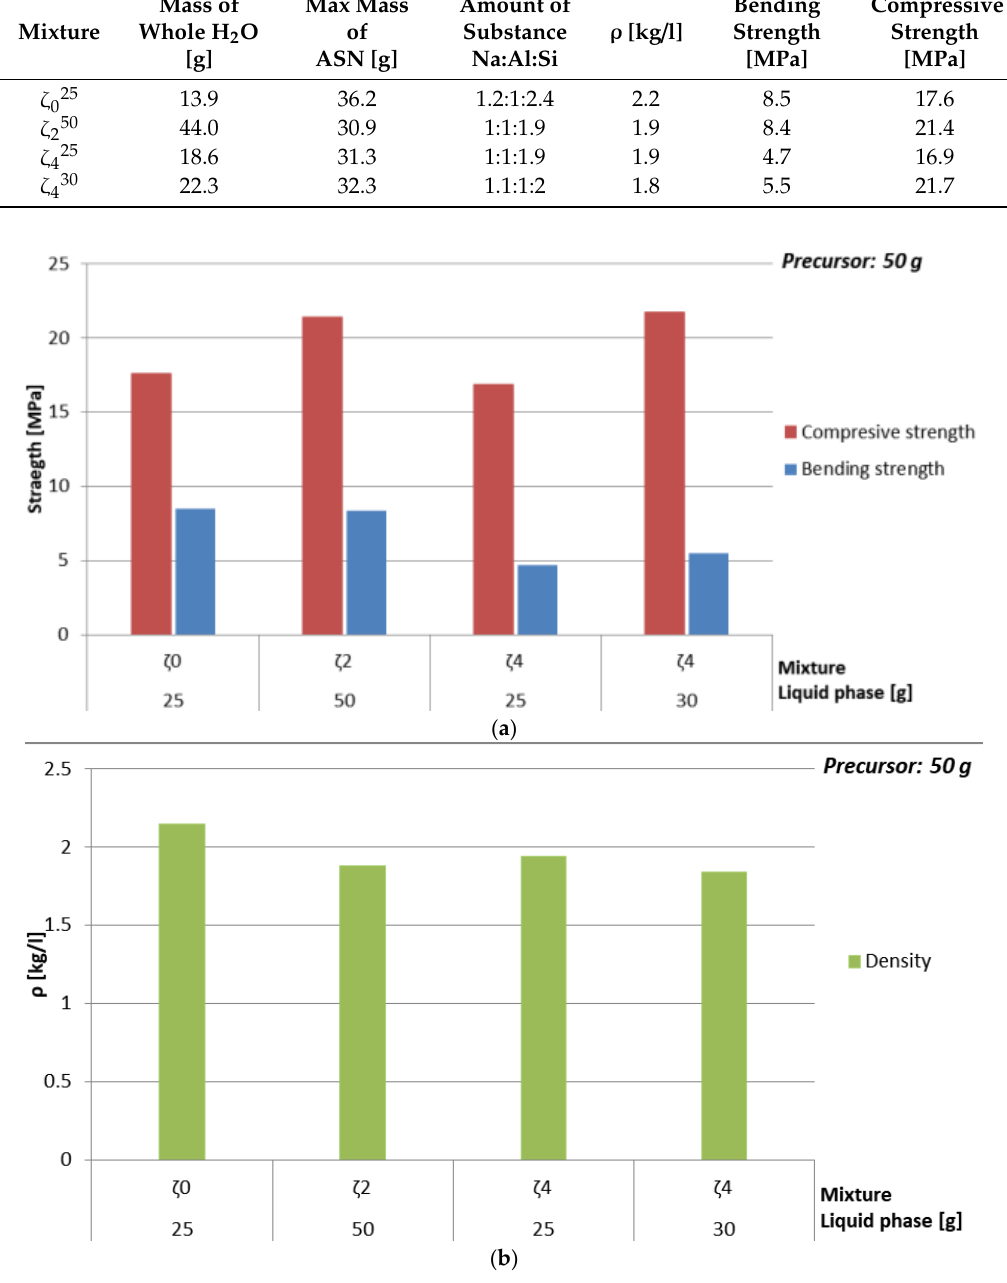
Figure 9. ( a ) Bending and compressive strength, and ( b ) density of AAM prepared with close to literature’s favourable amounts of substance ratios for the first group, Al and Si, cured on 70 °C for one day, measured one week after molding.